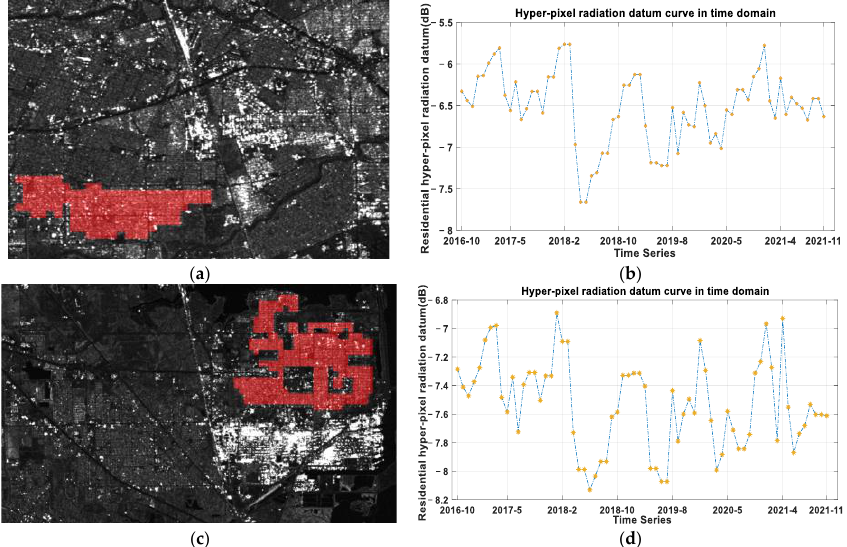
Figure 7. The time-domain performance of radiation datum extracted from different residential hy- per-pixels. ( a ) An independent residential hyper-pixel object in the scene. ( b ) The radiation datum curve of the hyper-pixel in ( a ). ( c ) Another independent residential hyper-pixel object in the scene. ( d ) The radiation datum curve of the hyper-pixel in ( c